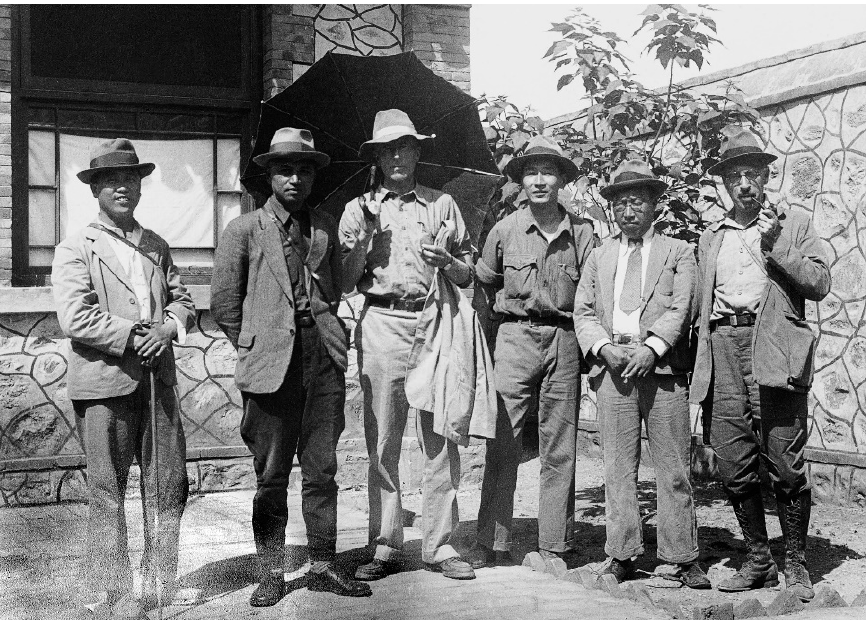
Figure 2. Paleontologists in Choukoudian, Beijing in 1934. From the left: Wenzhong Pei, Shiguang Li, Pierre Teilhard de Chardin, Meinian Bian, Zhongjian Yang, and George B. Barbour (credit to